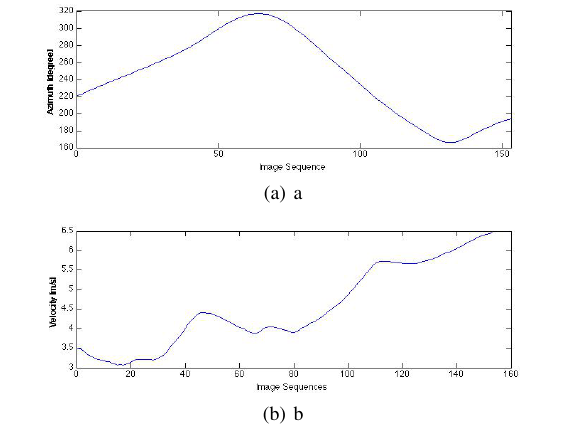
Figure 3: (a) Azimuth (b) Velocity of the